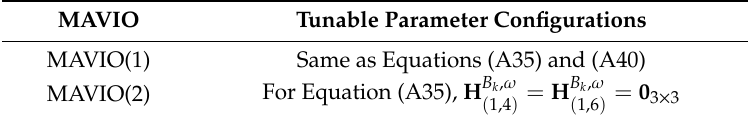
Table 2. The tunable parameter configurations of the monocular Ackermann visual–inertial odometry (VIO)